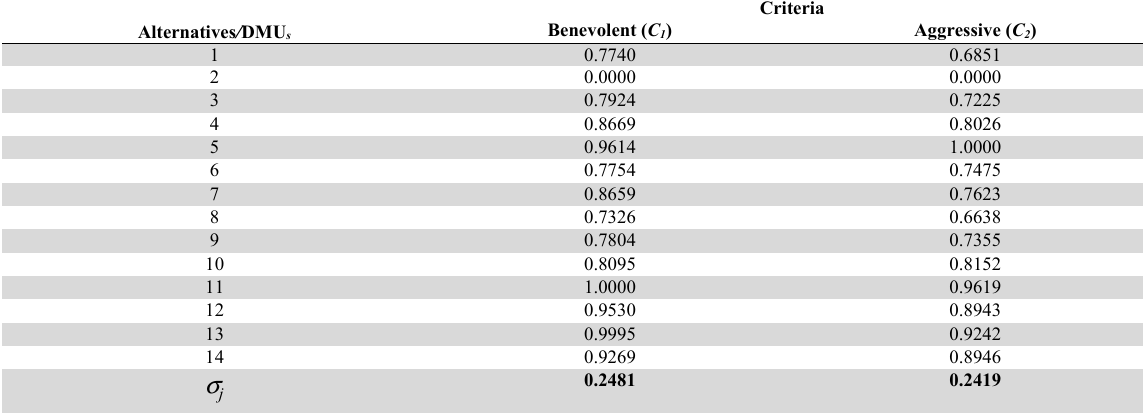
Considering the decision matrix of fourteen international passenger airlines in Table 10, the calculation steps are the same as Step 2 of Section 4.1. As a result, the normalized decision matrix was generated as shown in Table 11. Finally, the weights of each criterion were determined using the CRITIC method as listed in Table 12. Normalized decision matrix of fourteen international passenger airlines